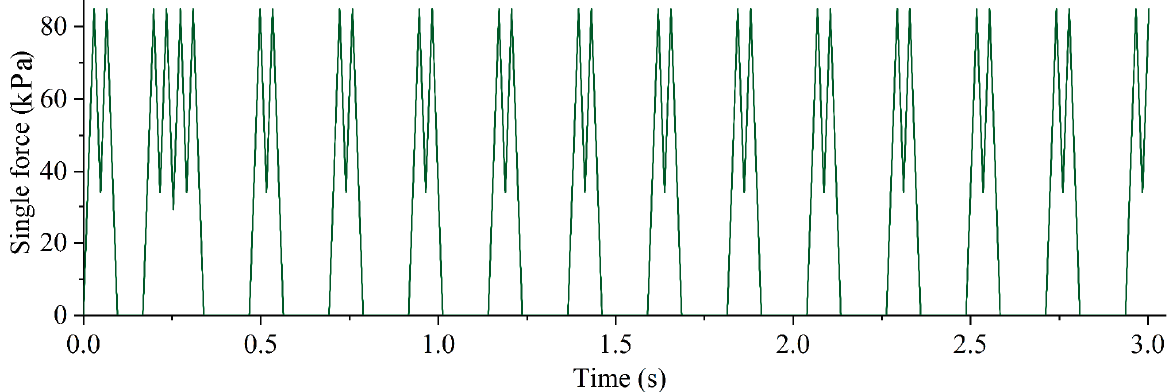
Figure 10. Time-history curve of excitation force load.